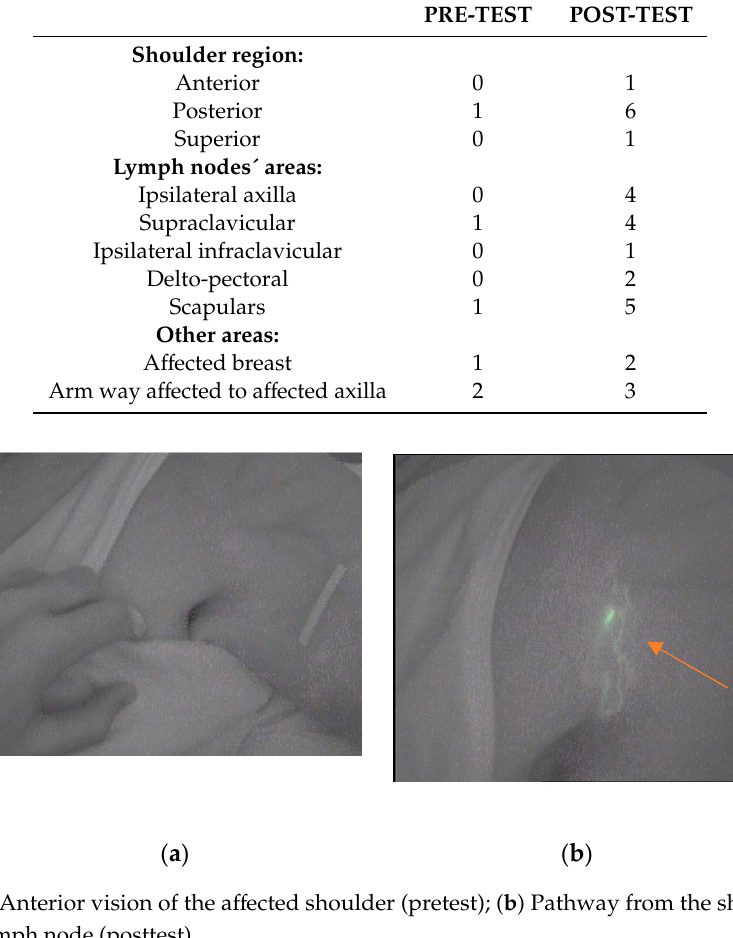
Figure 3. A pathway from the affected axilla to the ipsilateral scapular region.